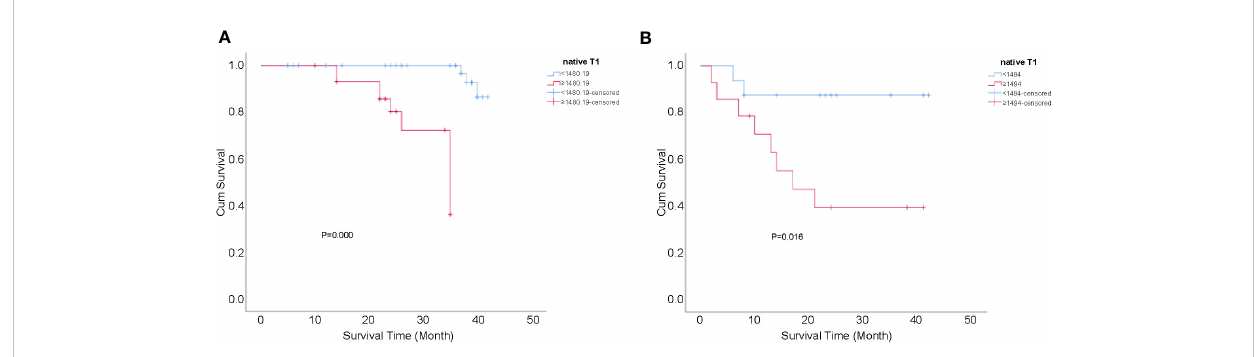
FIGURE 5 Kaplan-Meier curves for the cumulative recurrence-free survival rate of patients with CC. (A) native T1 values ≥ 1480.19 vs <1480.19 ms in the surgical group, P =0.000; and (B) native T1 values ≥ 1494.00 vs <1494.00 ms in the non-surgical group, P